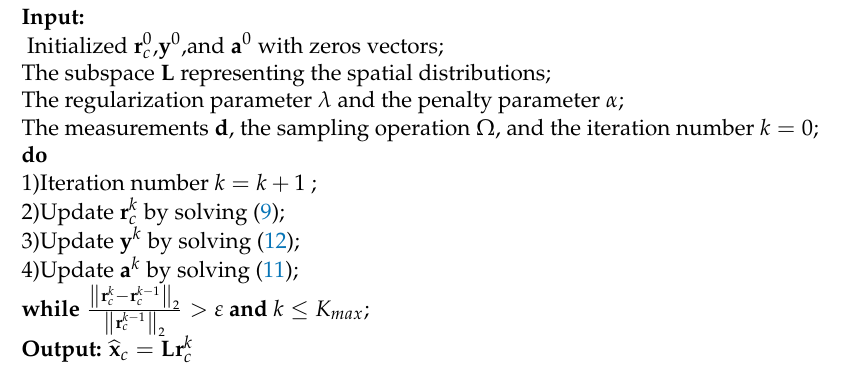
Table 1. The reconstruction algorithm to solve the optimization problem in